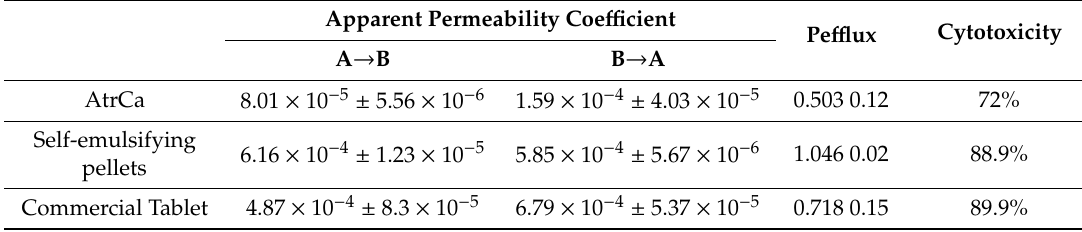
Table 8. Apparent permeability coe ffi cient (A → B, B → A), Pe ffl ux and cytotoxicity values of AtCa, commercial tablet and self-emulsified tablet.